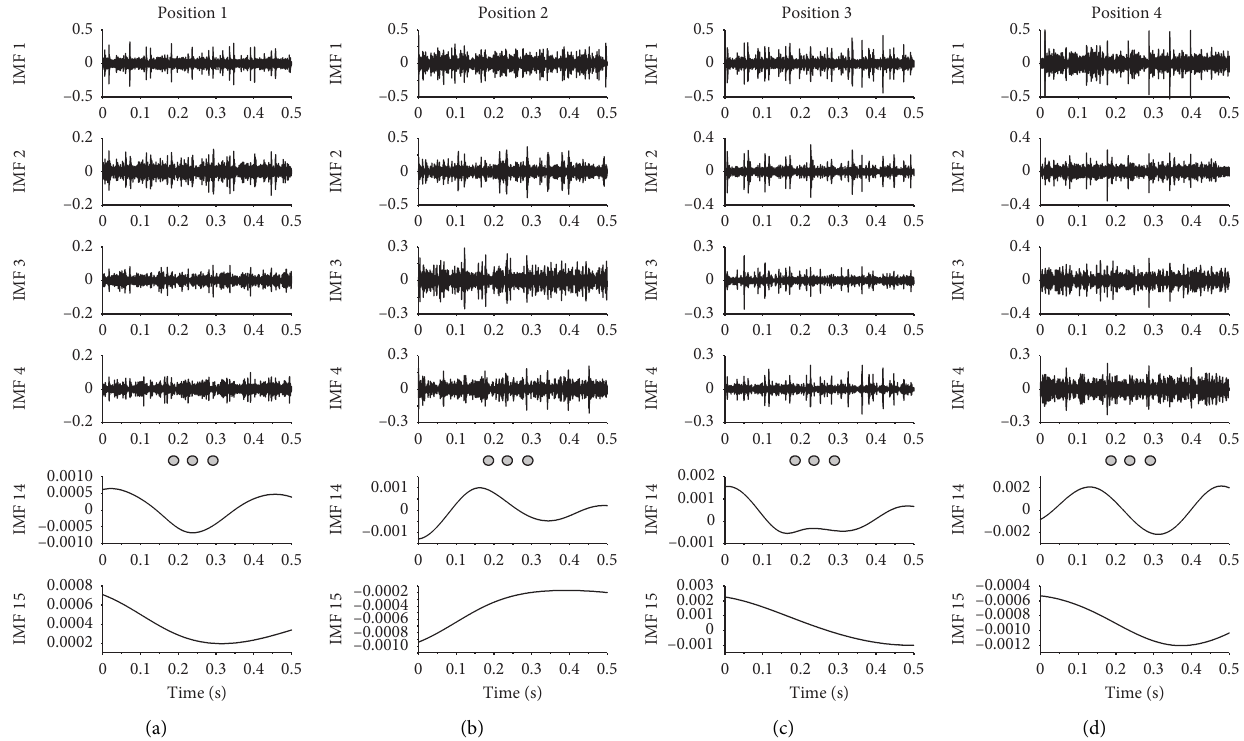
Figure 10: Decomposition result of multivariate signal using MEMD (normal state).